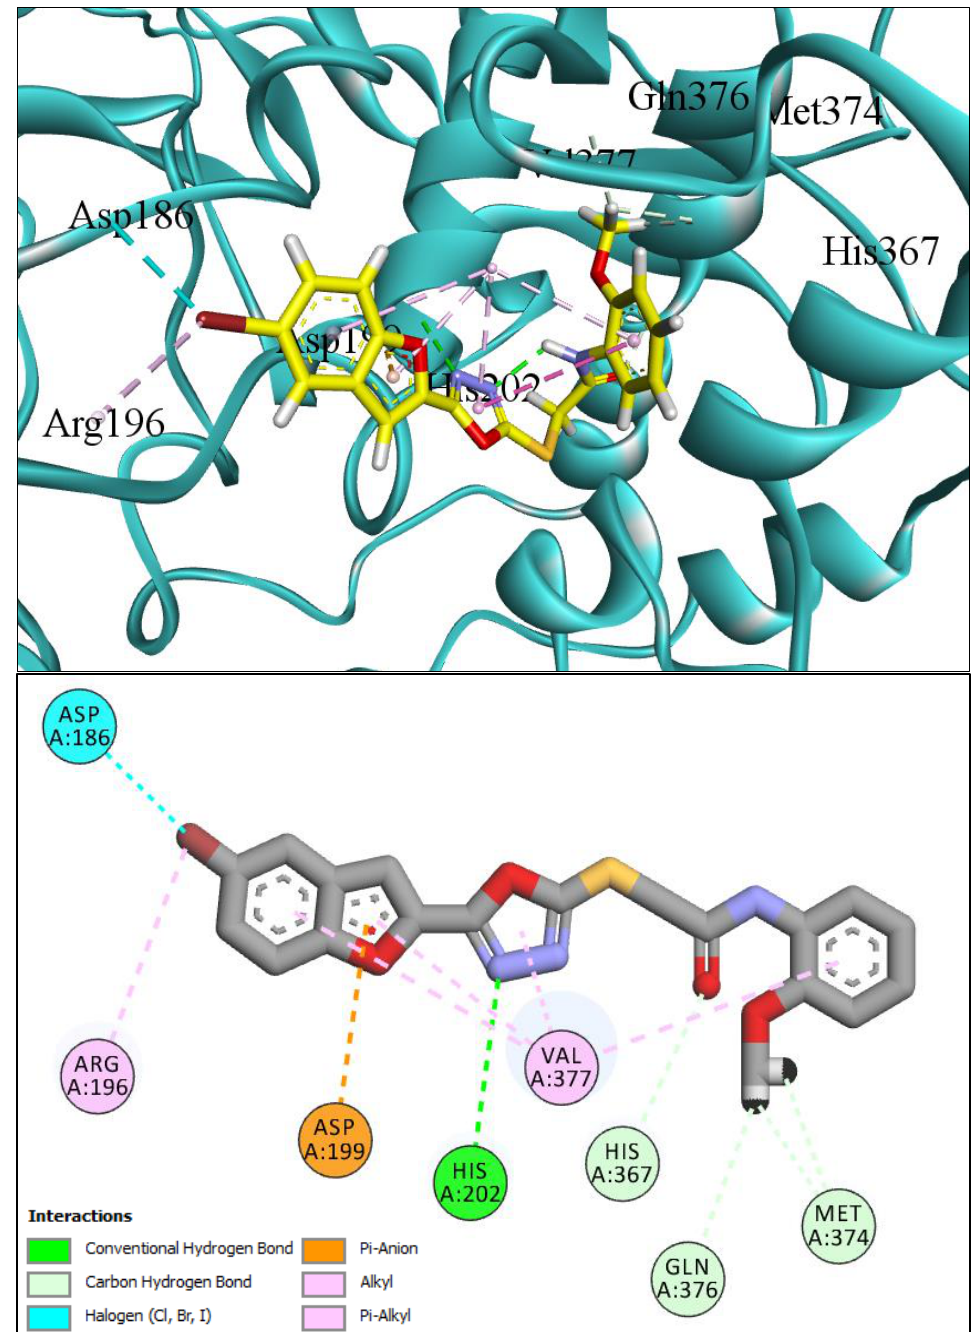
Figure 5. Three-dimensional conformational pose of BF5 with hTyrosinase ( Upper panel ) and two- dimensional pose ( Lower panel ).